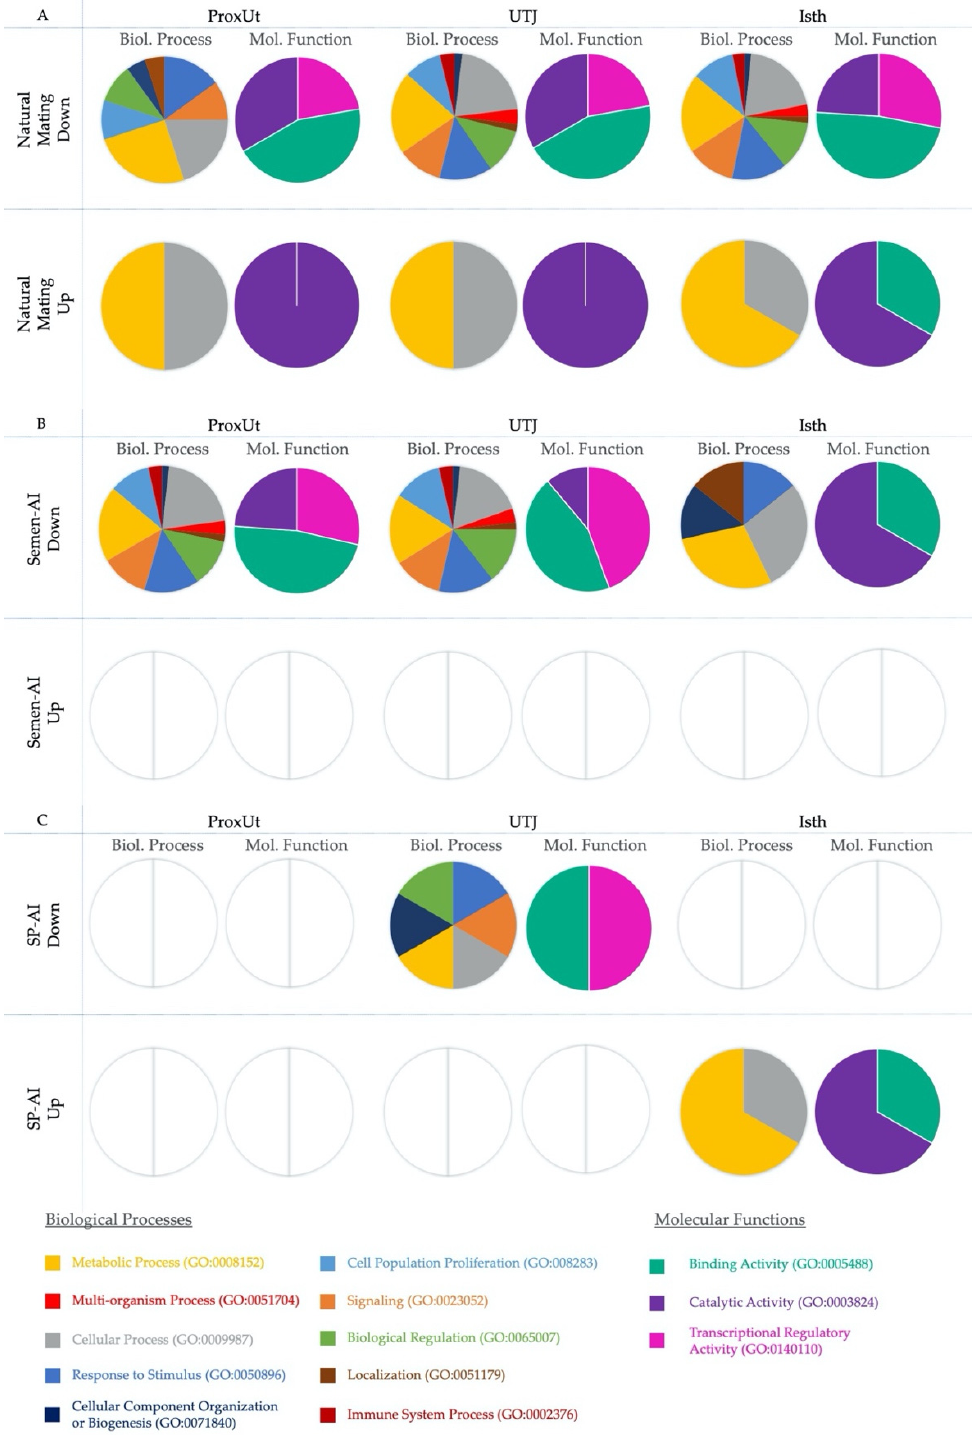
Figure 4. ( A – C ). Di ff erentially-expressed genes (DEGs) classified in PANTHER according to biological processes and molecular functions in natural mating ( A ), semen-AI ( B ), and SP-AI ( C ). Rows display the treatment and the up- or downregulation of the analyzed DEGs ( p < 0.05). Proximal uterus (ProxUt), utero-tubal junction (UTJ), and isthmus (Isth) tissues are shown in the columns. We have specified if the representations correspond to biological processes (Biol. Process; 1st, 3rd, and 5th column) or molecular functions (Mol. Function; 2nd, 4th, and 6th column) are depicted in colors. Empty charts indicate where no matches were found for those DEGs, or if these DEGs were absent from that experimental group.